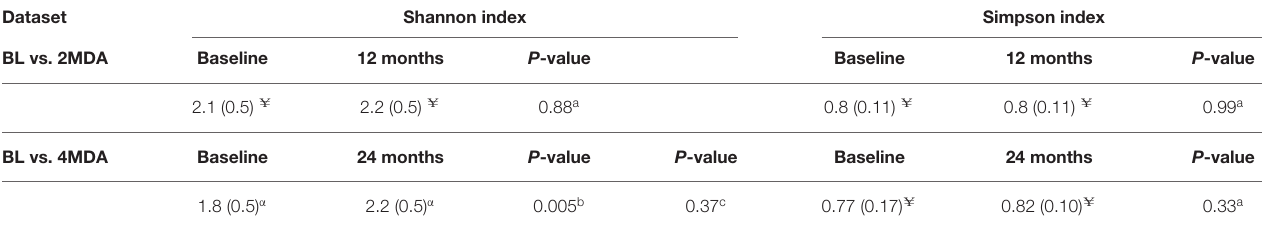
TABLE 4 | Alpha diversity distribution within the azithromycin treatment group.